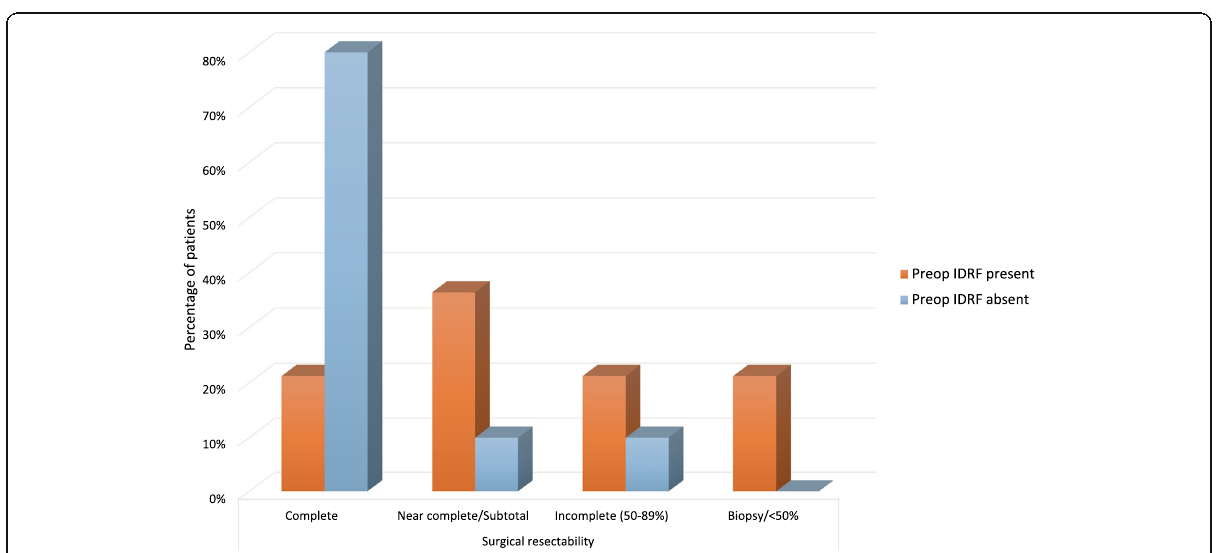
Fig. 7 Correlation between the pre-operative IDRFs and the surgical